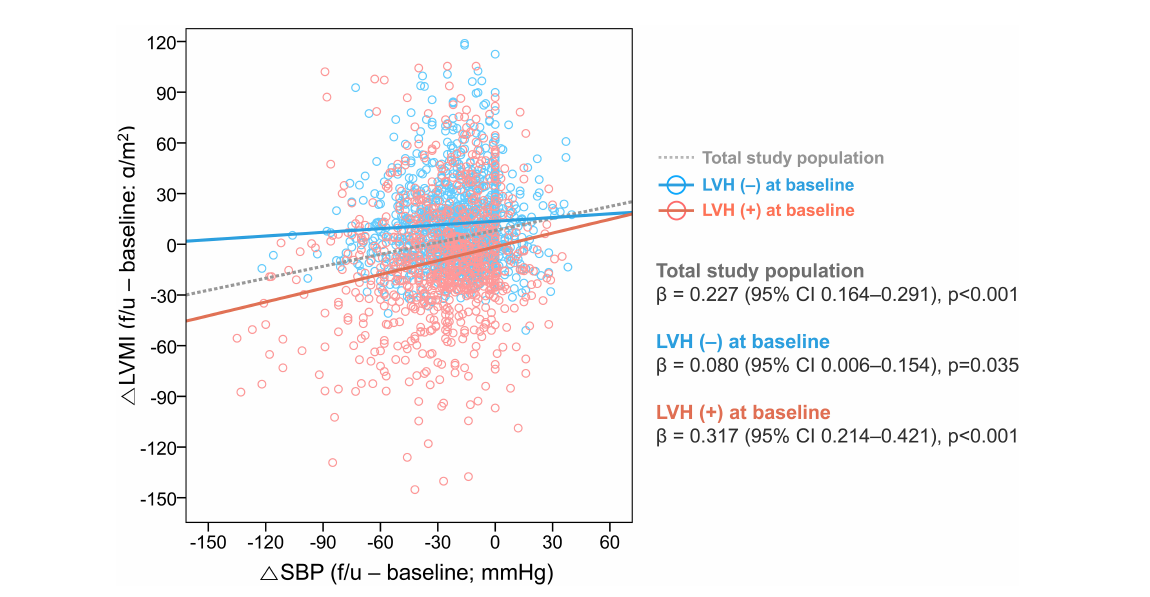
FIGURE2 Association between changes in SBP and LVMI. The relationship between the (cid:77) SBP and (cid:77) LVMI was assessed in the total study population and subgroups according to the presence of LVH at baseline. LVH, left ventricular hypertrophy; CI, confidence interval; SBP, systolic blood pressure; LVMI, left ventricular mass index.